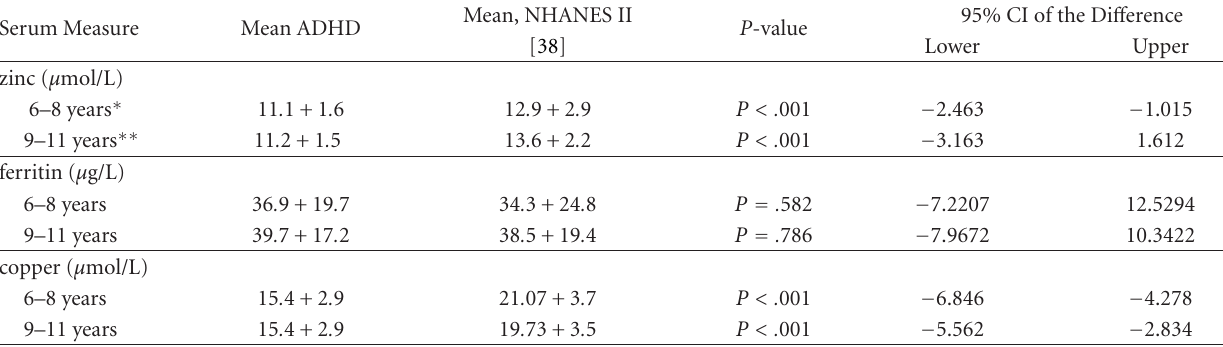
Table 4: Comparison of serum micronutrients of ADHD children with age-paired NHANES II (1) . Serum Measure Mean